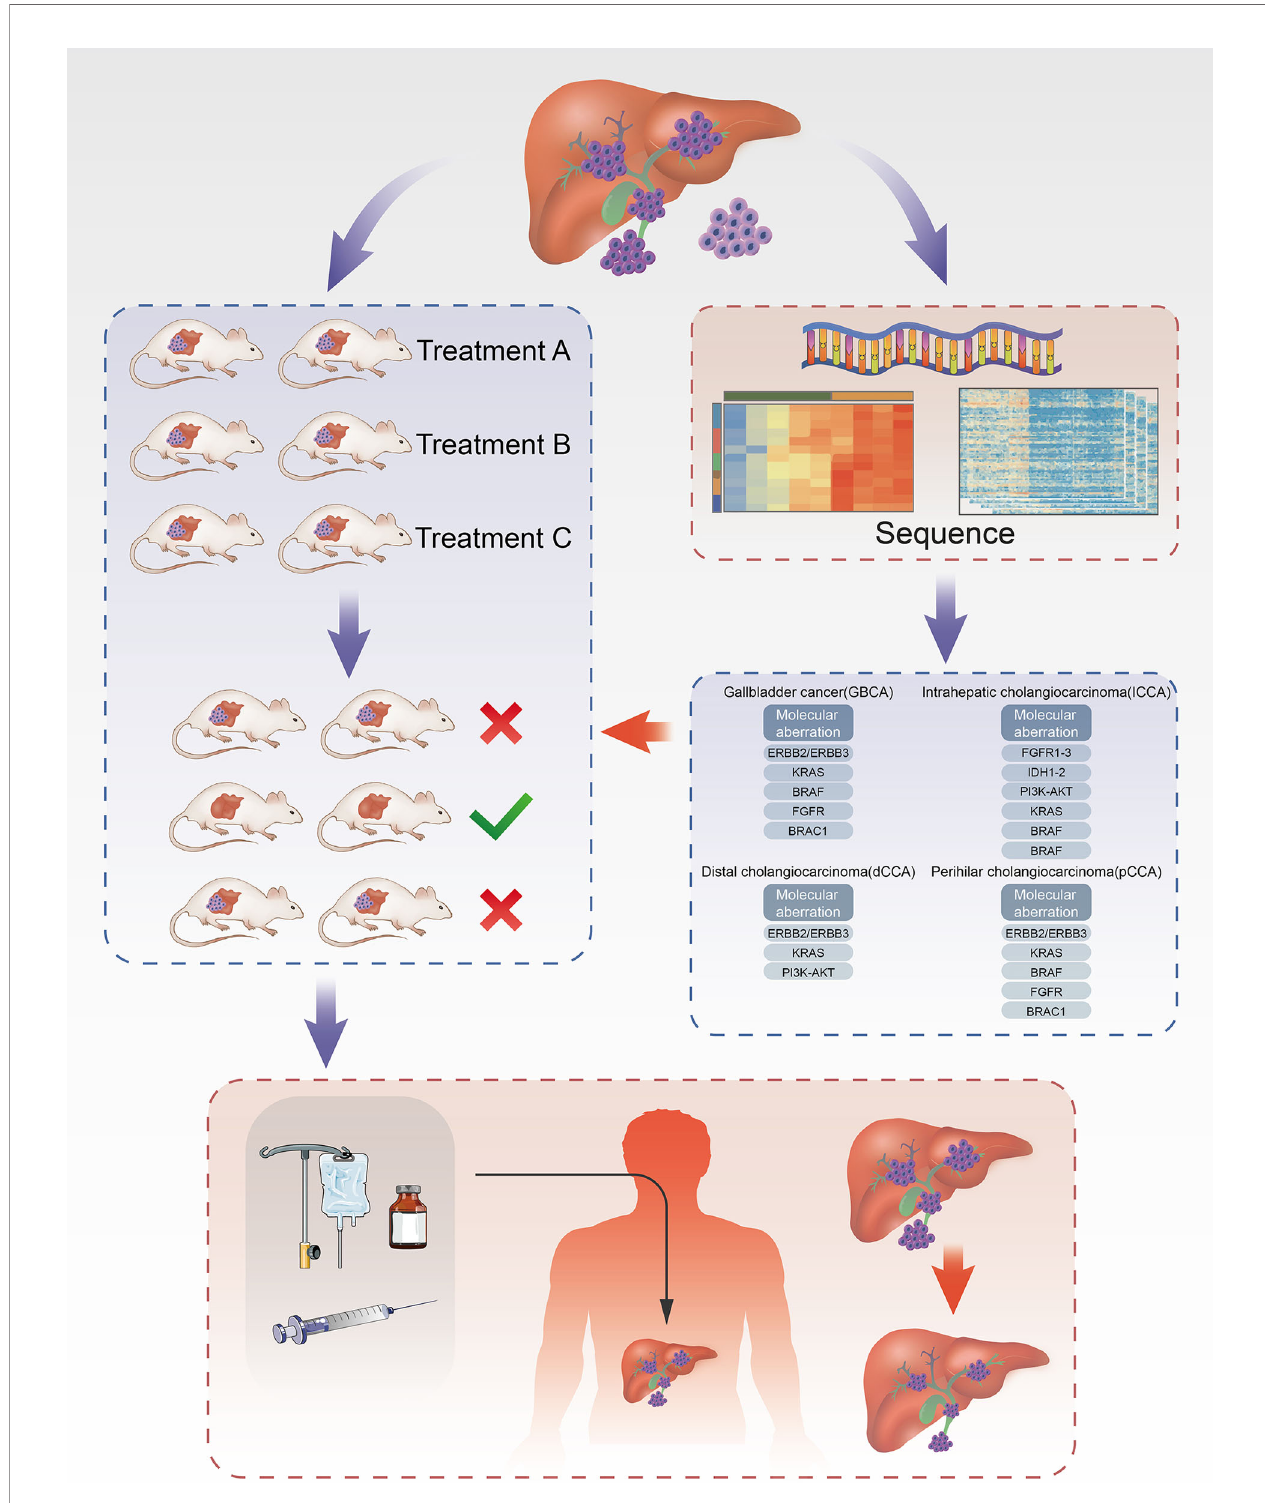
FIGURE 1 | Establishment of ICC PDX models and application of drug screening. Part of the tissue of ICC after cholangiocarcinoma surgeries was transplanted into each group of mice correspondingly to cultivate cholangiocarcinoma. In the meanwhile, part of tissue was used for the analysis of targets for ICC using NGS technique to fi lter drugs with higher sensitivity and then administered on the treatment group. Through the analysis of drug ef fi cacy against intrahepatic cholangiocarcinoma in the treatment group, the drugs with high sensitivity can be obtained and further acted on the human body.